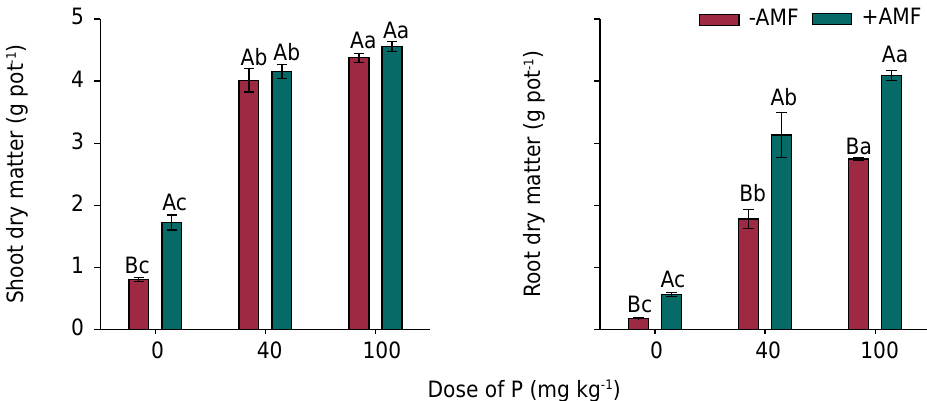
Figure 3. Shoot and root dry matter of Crotalaria juncea plants growing in a soil with high copper (60 mg kg -1 ) levels under different levels of phosphorus with and without AMF inoculation. Vertical bars above the columns indicate the standard deviation. Means followed by the same lowercase letter compare doses in the same condition inoculation and uppercase letters compare inoculation within the same dose of P (Tukey 5